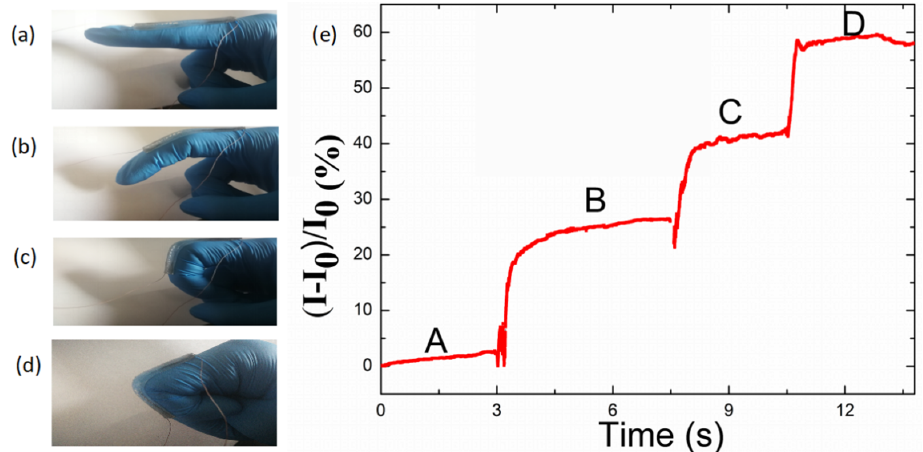
Figure 9. ( a–d ) Photograph of the TPU/graphene strain sensor with an intertwined-coil configuration attached to a volunteer’s forefinger, with different bending degrees. ( e ) Sensing performance of the TPU/graphene strain sensor with an intertwined-coil configuration for different bending degrees of the forefinger.